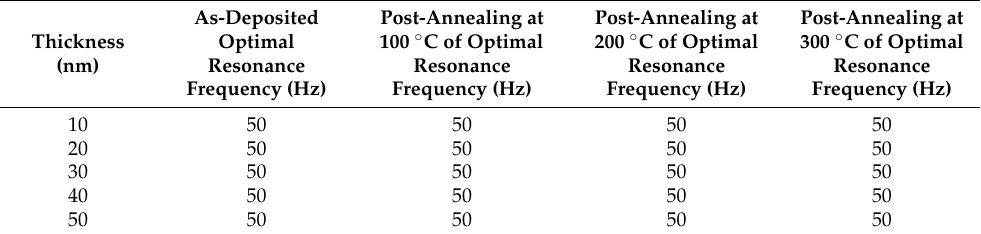
Figure 9. Maximum alternate-current magnetic susceptibility. Table 1 displays the maximum χ ac for the optimal resonance frequency (f res ) under four different conditions. The highest spin sensitivity is present in the maximum χ ac at the ideal resonance frequency [36]. At each thickness, the f res was 50 Hz and calculated to be less than 500 Hz. As a result, it has the potential to be used in low-frequency magnetic applications. Table 1. The optimal resonance frequency for various thicknesses of